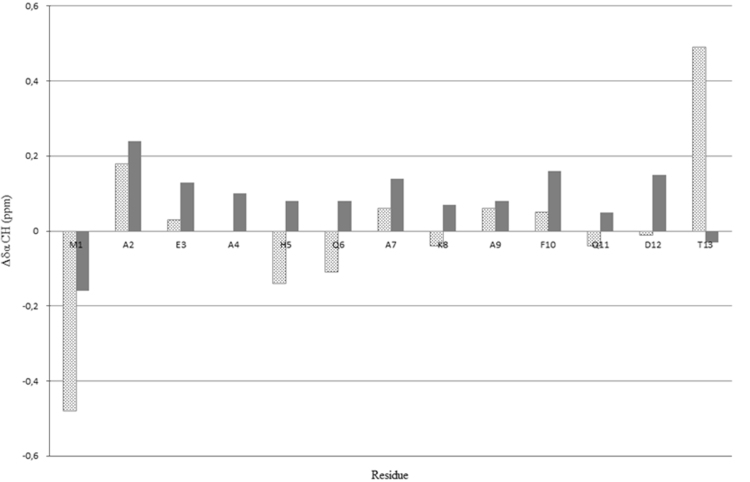
Comparison of deviations of αCH proton chemical shifts from random coil values [8] for MTP2 in DMSO (dotted bars) and TFE/H2O 1:1 (gray bars).